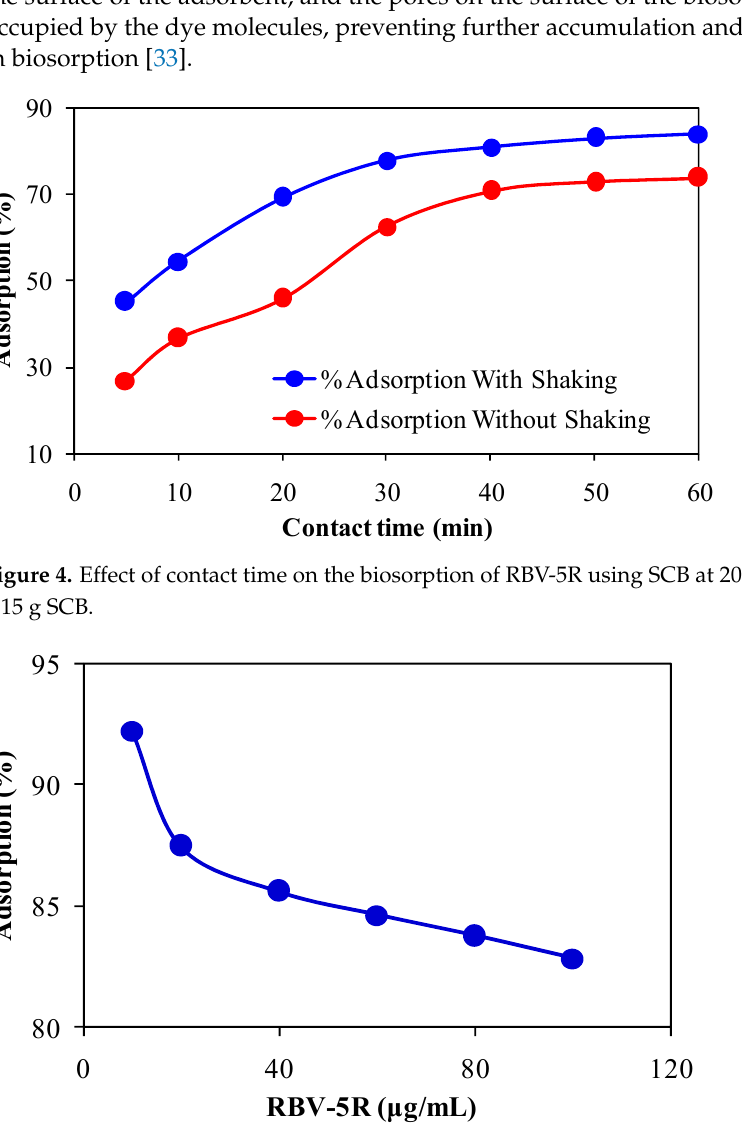
Figure 5. Effect of initial dye concentration on the biosorption of RBV-5R by SCB at pH 6, 0.15 g SCB, and 60 min of contact time with shaking.